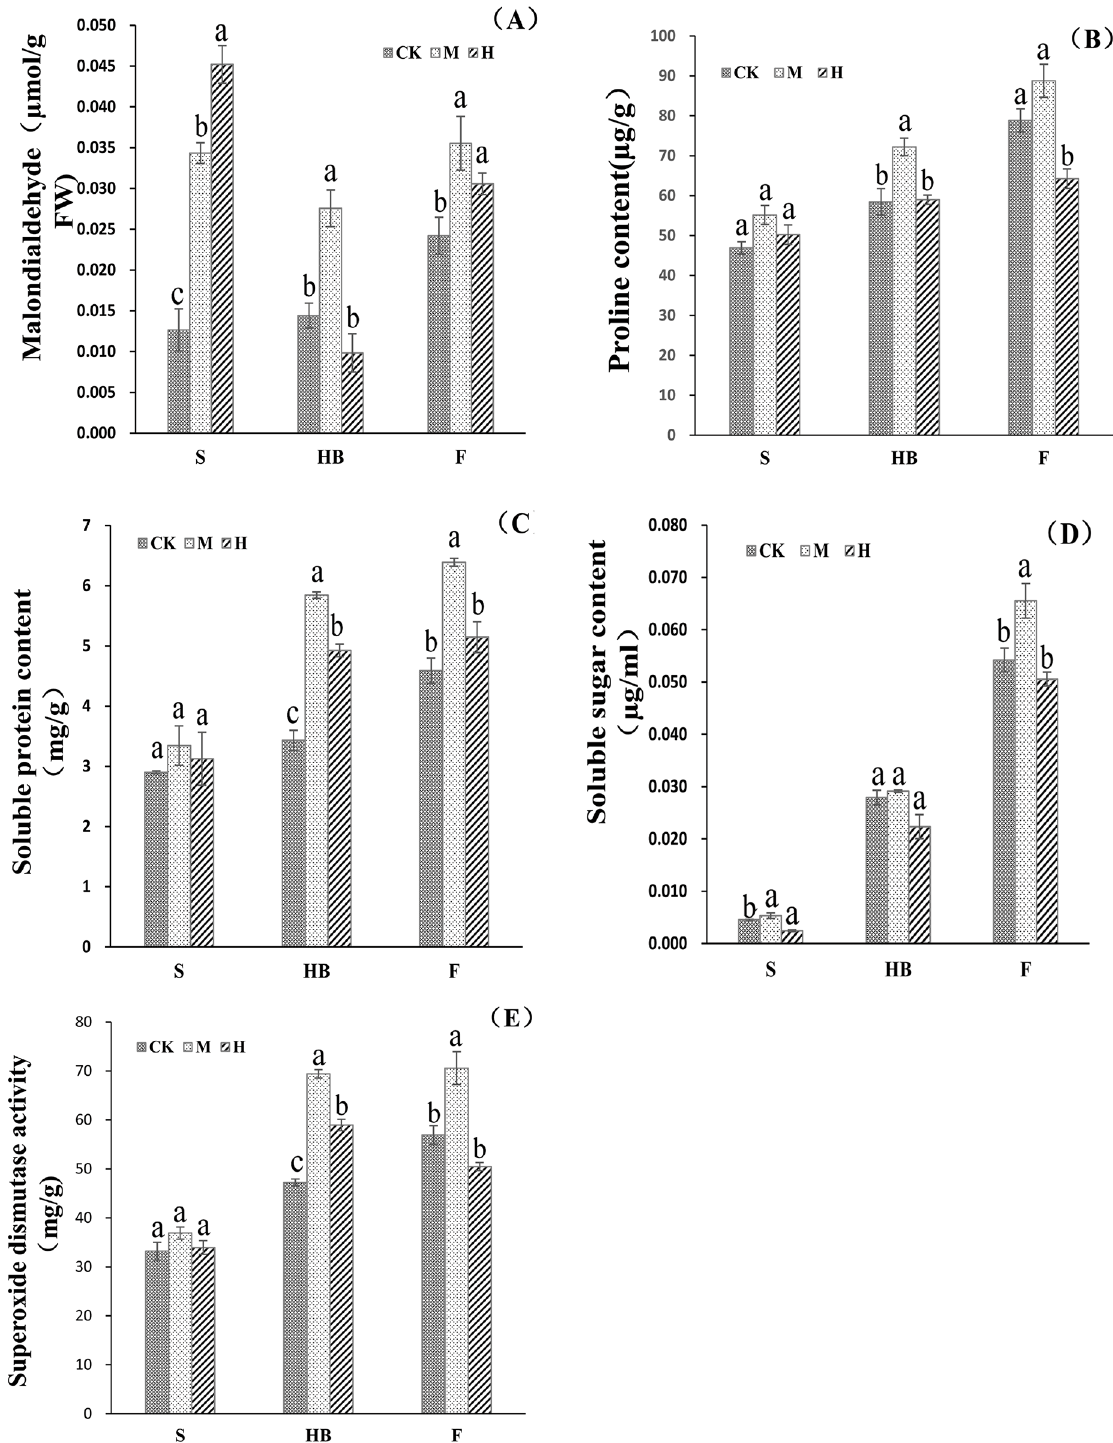
Fig 2. Changes of physiological indices of resistance to stressunder the condition of increasedatmospheric CO 2 levels and high temperature in key growth stages. Note: (a)–(e) represents MDA, Pro, SP, SS and SOD, respectively;S, HB, and F stand for the seeding, headingand blooming,as well as the filling stage, respectively. Note: The numberof days represents the days of different growth stages after rice transplanting; - symbol representsshortening;CK stands for control treatment, 400 μ mol (cid:1) mol − 1 +0˚C; M stands for moderate treatment, 550 μ mol (cid:1) mol − 1 +2˚C; H stands for intensive treatment, 650 μ mol (cid:1) mol − 1 +4˚C. Note: a, b and c indicate significantdifferences at the 0.05 level in the same growth stage. https://doi.org/10.1371/journal.pone.0187724.g002 PLOS ONE | https://doi.org/10.1371/journal.pone.0187724 November16, 2017 8 /